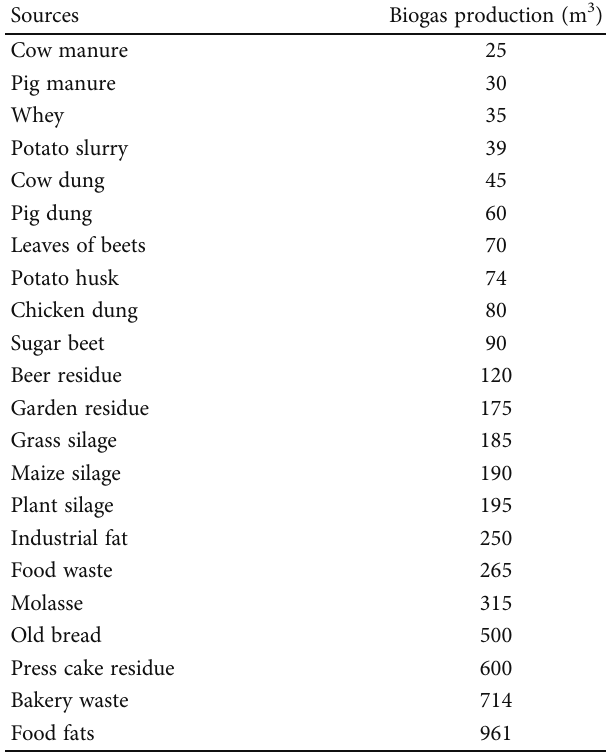
Table 1: Di ff erent sources for biogas production adopted from the literature [13,